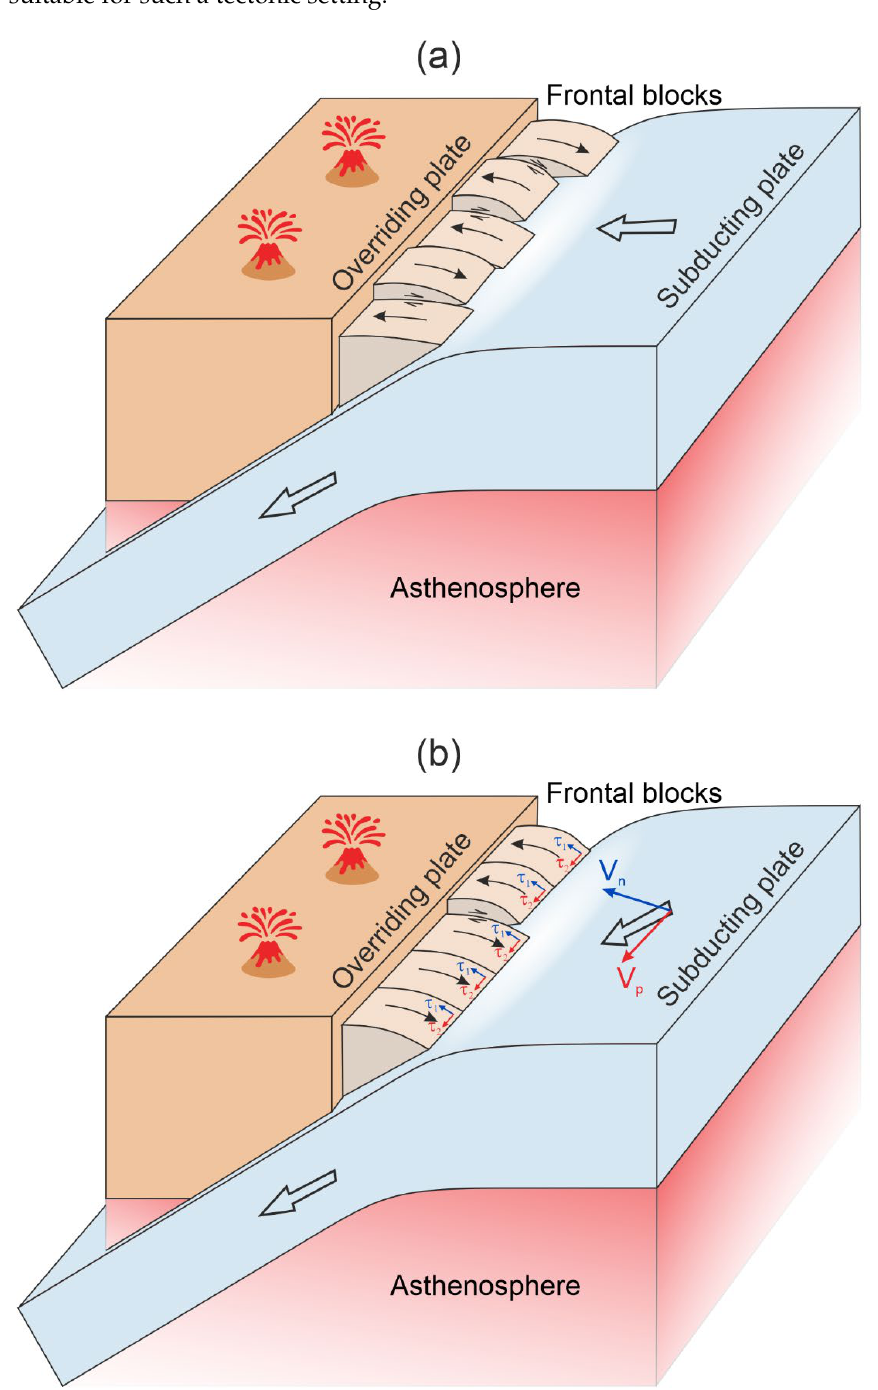
Figure 3. Sketch of the keyboard model featuring the motion of the blockwise structure in the frontal part of the island arc under normal ( a ) and oblique ( b ) subduction. Vn—arc normal rate of motion of subducting plate; Vp—arc parallel rate of motion of subducting plate; τ1 —shear stresses at the bottom of seismogenic blocks caused by orthogonal subduction of the oceanic plate; τ2 —initial shear stresses at the bottom of seismogenic blocks caused by their longitudinal compression.